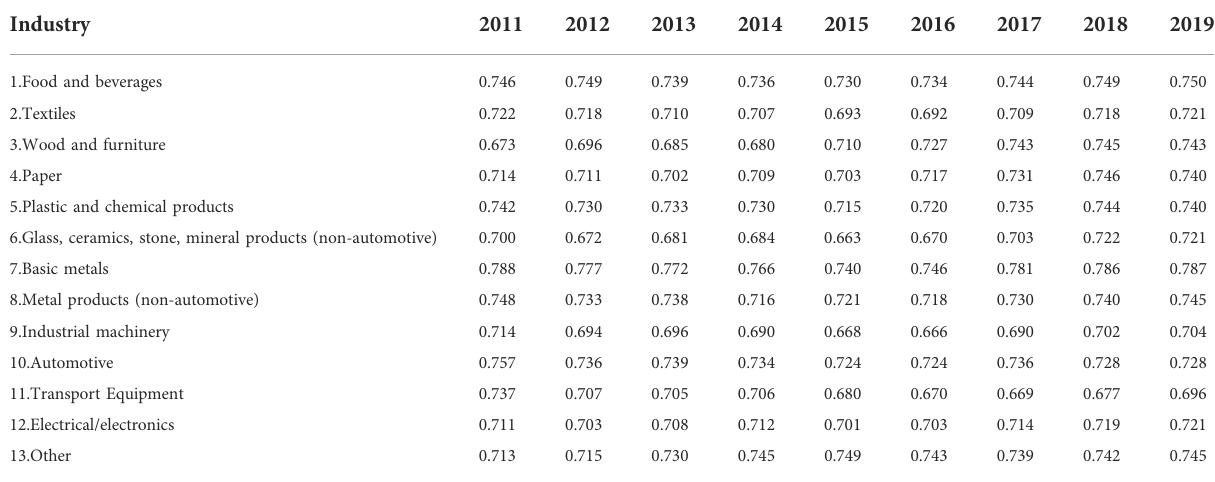
TABLE 1 China ’ s manufacturing capacity utilization.